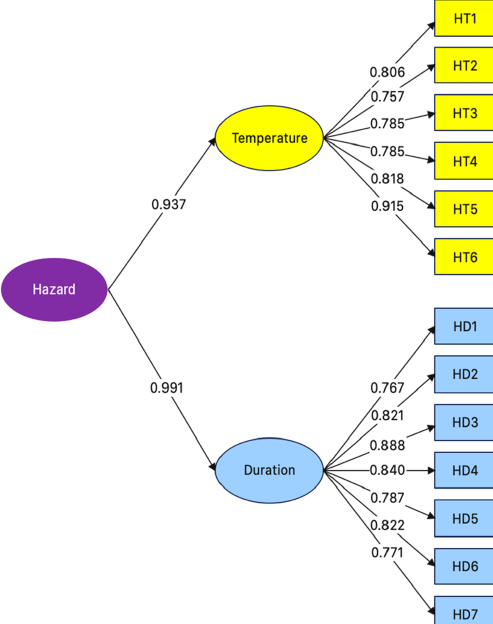
Figure 2. Structural equation model and the factor loadings of the UHI hazard indicators and di- mensions.